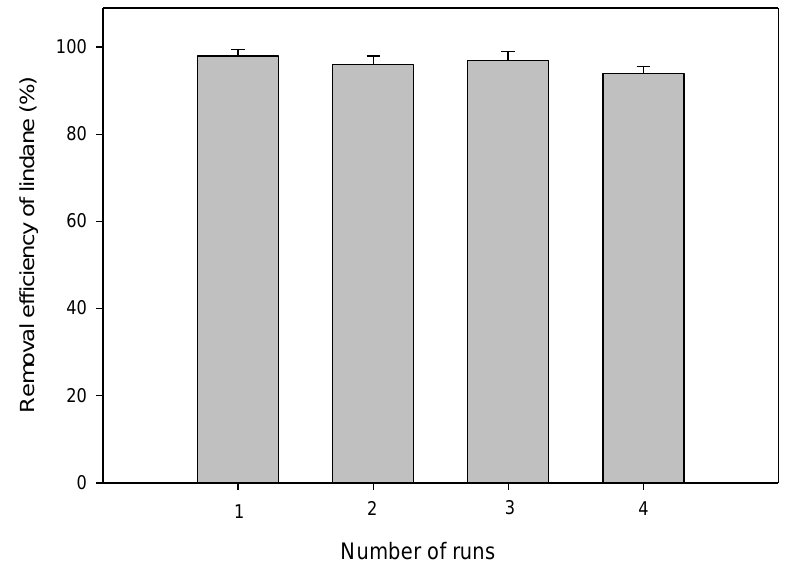
Figure 7. Test of reusability for the simulated solar light-activated TiO 2 /S 2 O 82− /H 2 O 2 photocatalyst of lindane. [lindane] 0 = 1.0 µM; mass of TiO 2 film = 9.02 mg; thickness of TiO 2 film = 1.02 µm; area of lindane. [lindane] 0 = 1.0 µ M; mass of TiO 2 film = 9.02 mg; thickness of TiO 2 film = 1.02 µ m; area of TiO 2 film = 3750 mm 2 ; pH = 5.8. TiO 2 film = 3750 mm 2 ; pH =